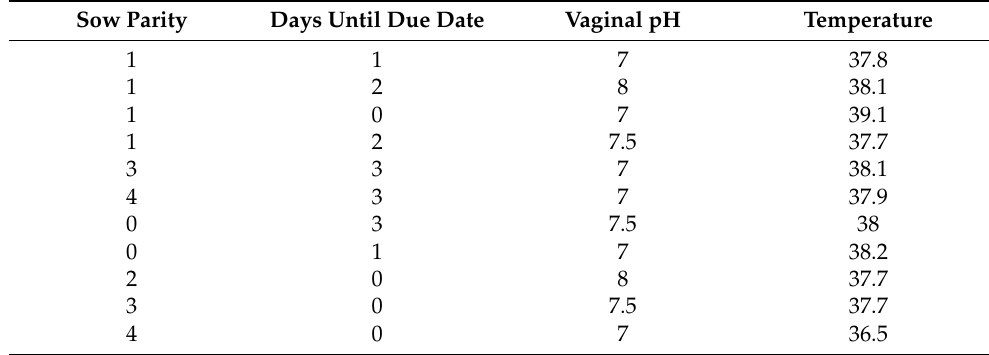
Table A2. Data collected on Large White x Landrace sows for optimization of